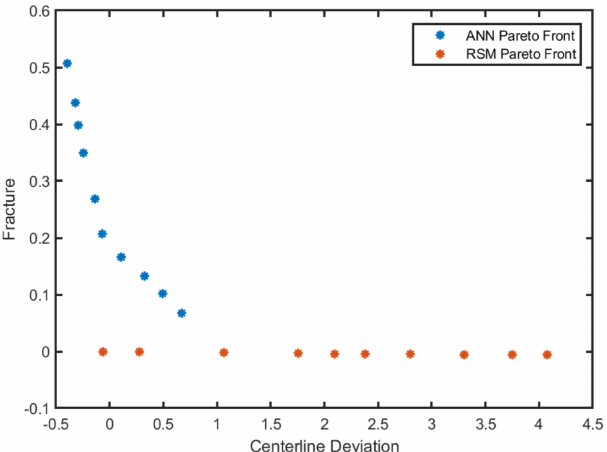
Figure 19. Optimized Pareto front: RSM,